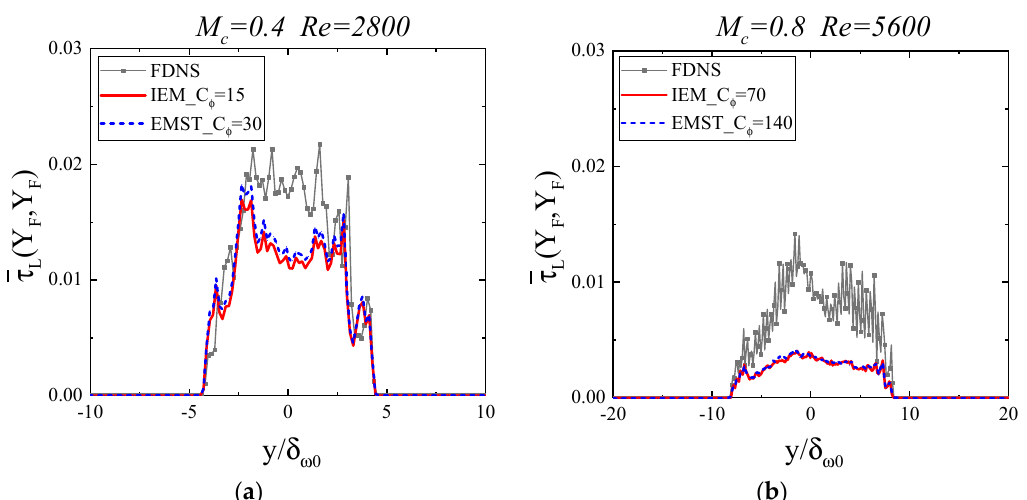
Figure 8. Cross-stream profiles of Reynolds-averaged SGS unmixedness values of the filtered flue mass fraction for ( a ) M c = 0.4 case and ( b ) M c = 0.8 case, respectively.